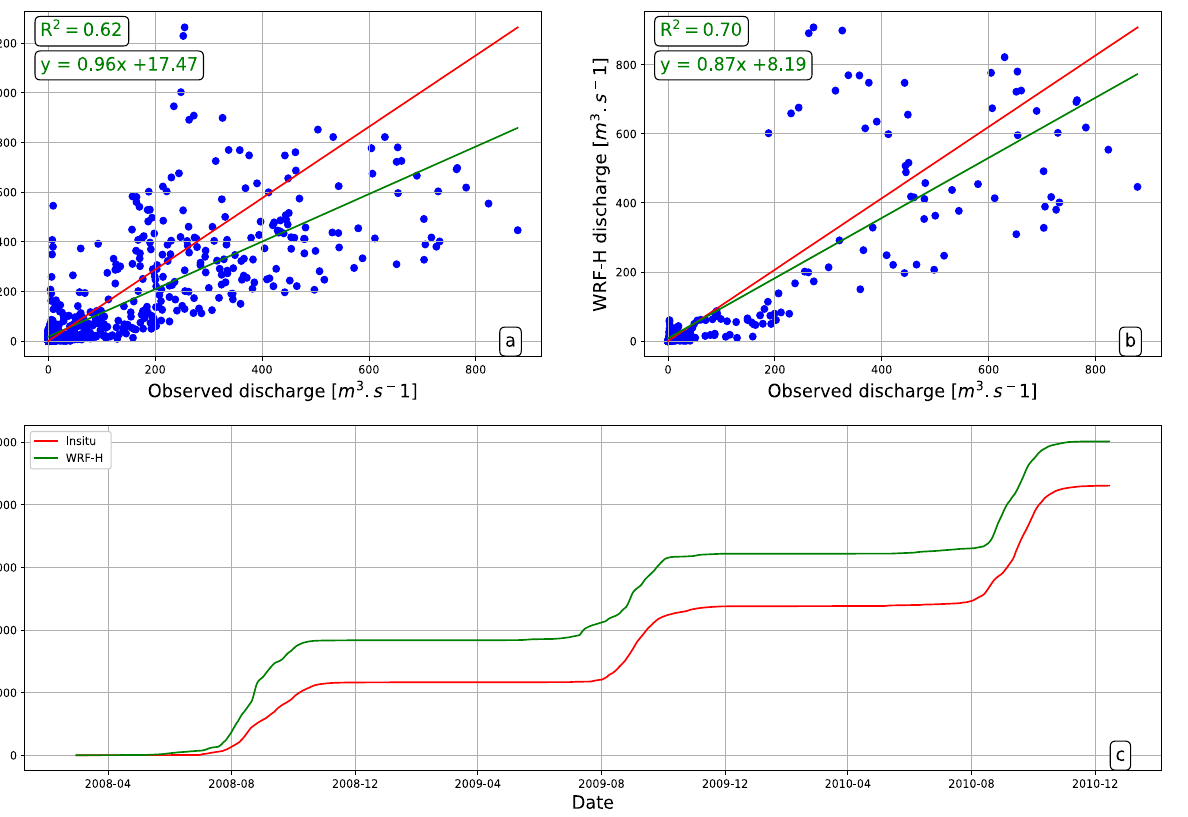
Figure 11. Scatter plot showing comparison of simulated and observed discharges ( a ) for the period 2008–2010, and ( b ) for the flooding year 2010, and ( c ) the cumulative of simulated and observed discharge at Savè.